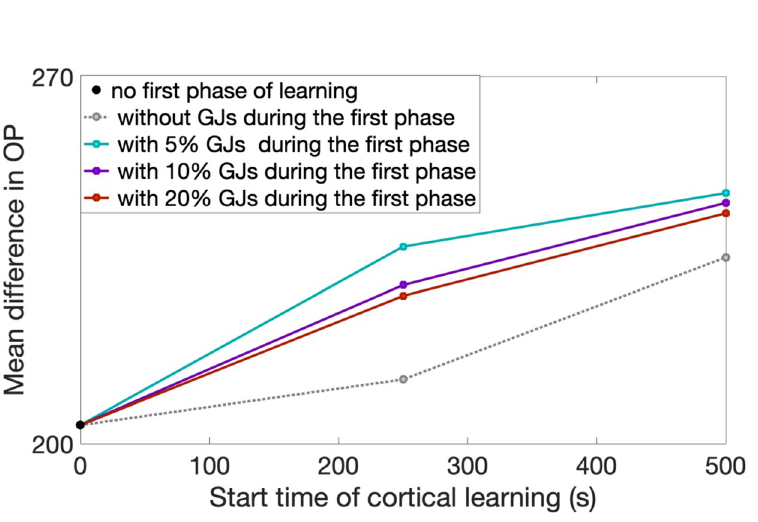
Fig 9. The mean difference in OP for varying start times of the cortical synaptic learning comparing different percentages of GJ-coupling between sister cells. Note that we only show results for greater than 250 seconds of cortical learning to ensure the GJ-coupling has time to affect the